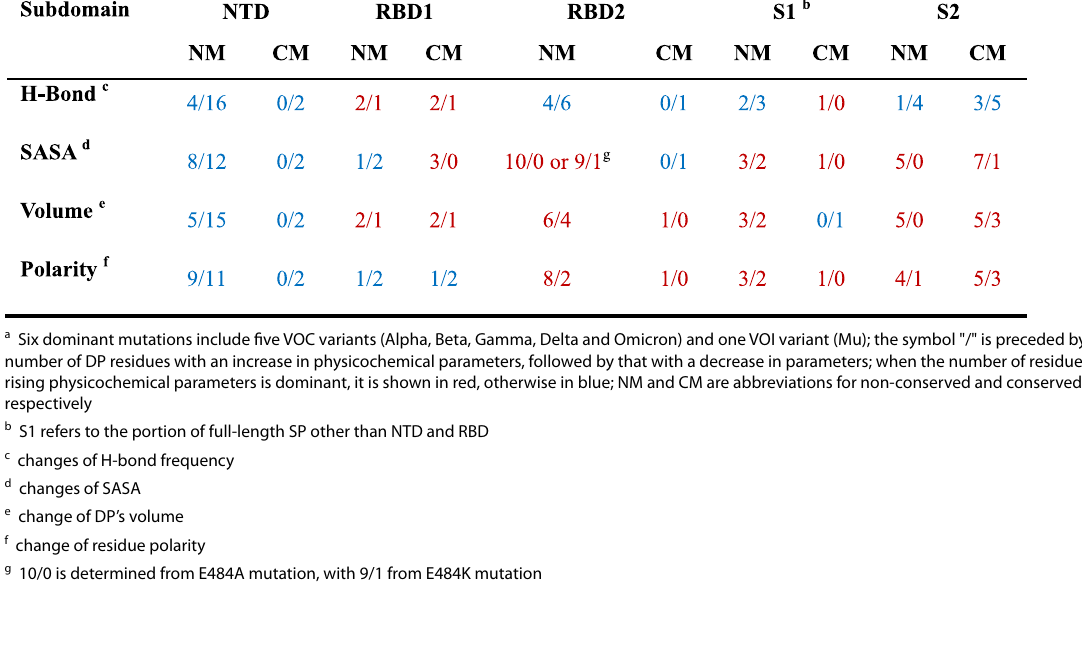
Table 1 The fluctuation of physicochemical parameters caused by six dominant mutations a